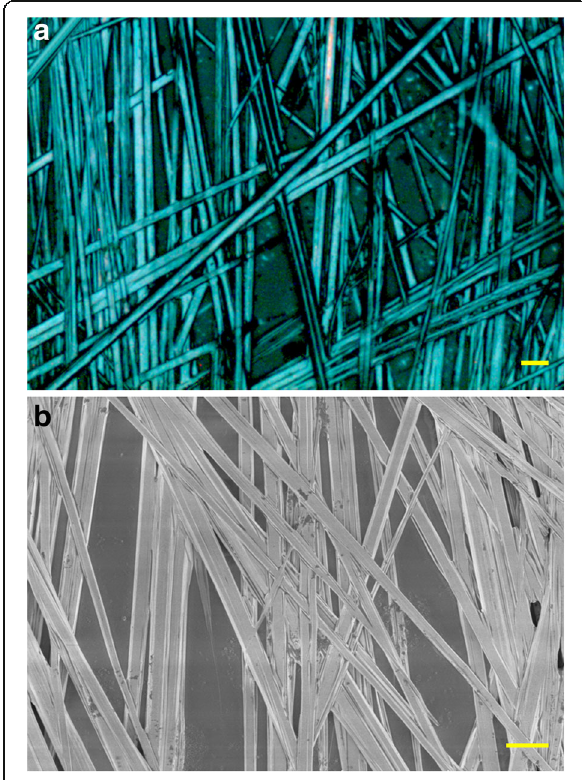
Fig. 1 a Optical microscope and b SEM image of MAPbI 3 microwires on glass slide. Scale bars represent 10 μ